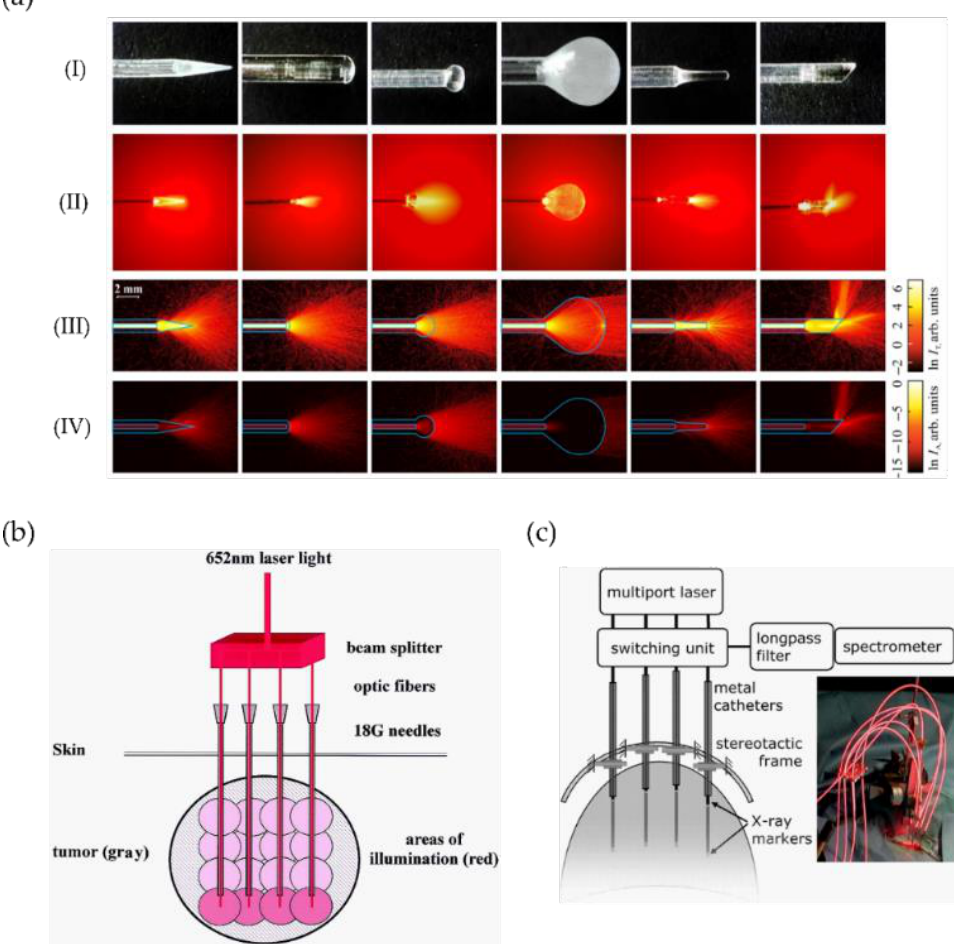
Figure 6. ( a ) Examples and application of advanced sapphire capillary needles for light delivery. (I) Sapphire tips; (II) laser light (632.8 nm) distribution produced by the sapphire tips in a diluted intralipid solution; corresponding to the (III) transmitted ln I T and (IV) absorbed ln I A intensities. The image and caption are adapted from their original created by Dolganova et al. [122] under a Creative Commons Attribution 4.0 Unsorted licence. ( b ) Schematic of I-PDT system including four fibres inserted into gauge-needles for simultaneous delivery light to treat head and neck cancer (image adapted from [124]). ( c ) Schematic of I-PDT system for brain tumour including real-time spectroscopic monitoring and clinical setting (optical fibres, catheters, and fixation device) during treatment (image adapted from [125]).